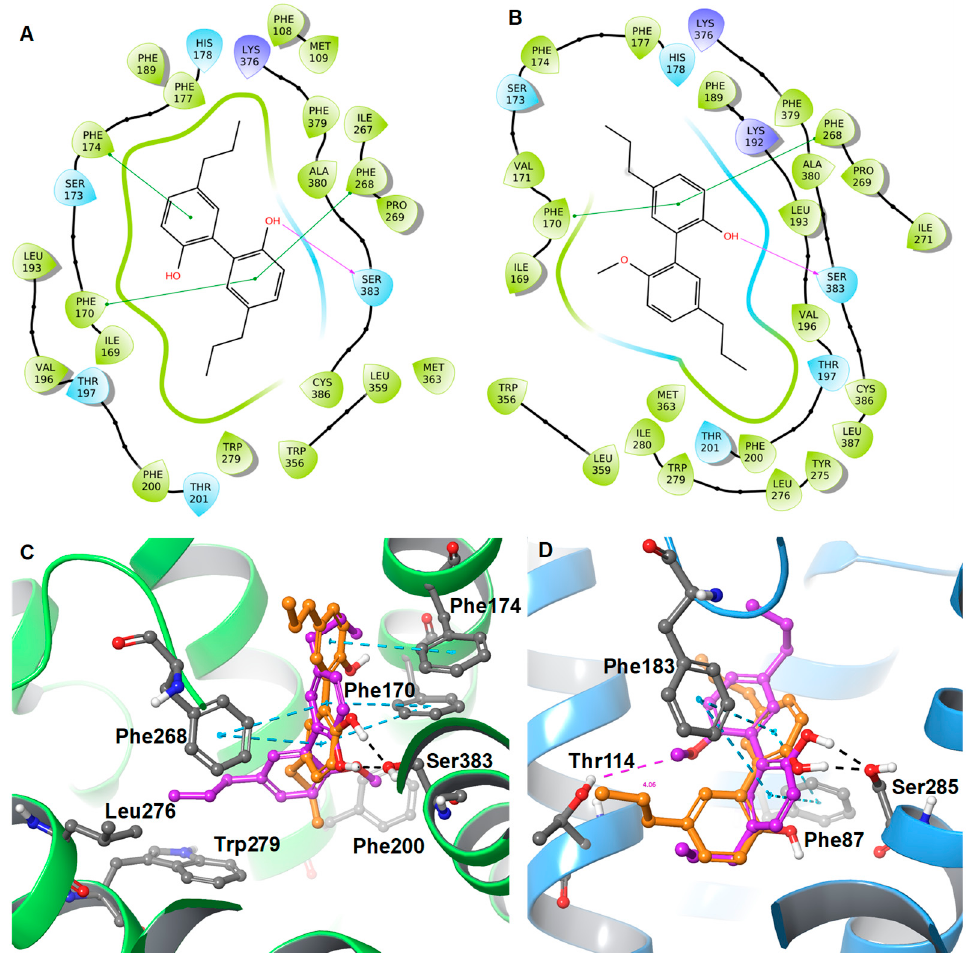
Figure 5. 2D interaction diagrams of ( A ) 4 and ( B ) 4a along with the 3D overlaid representations of ( C ) 4 (carbon in orange) with 4a (carbon in plum) against the CB1R and ( D ) 4 (carbon in orange) with 4a (carbon in plum) against the CB2R. The key residues are shown in the ball and stick model (carbon in grey).